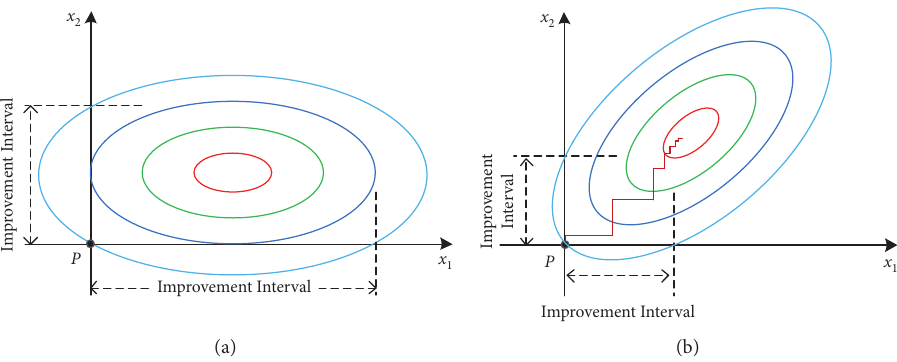
Figure 4: (a) Fitness landscape of the quadratic function and (b) fitness landscape of the rotated quadratic function [52].